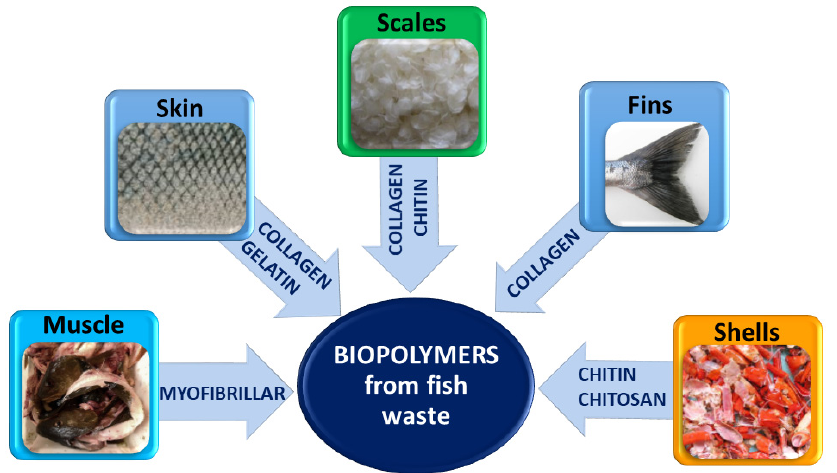
Figure 1. Biopolymers with potential food packaging application derived from fish industry